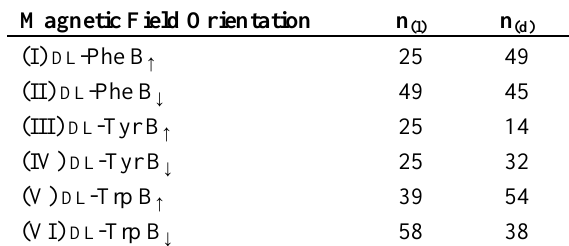
Table 2. Magnetic field orientation effect (upwards B external field) on the water-air induced crystallization of NaClO hydrophobic amino acids impurities, DL -Phe, DL -Tyr and DL -Trp.